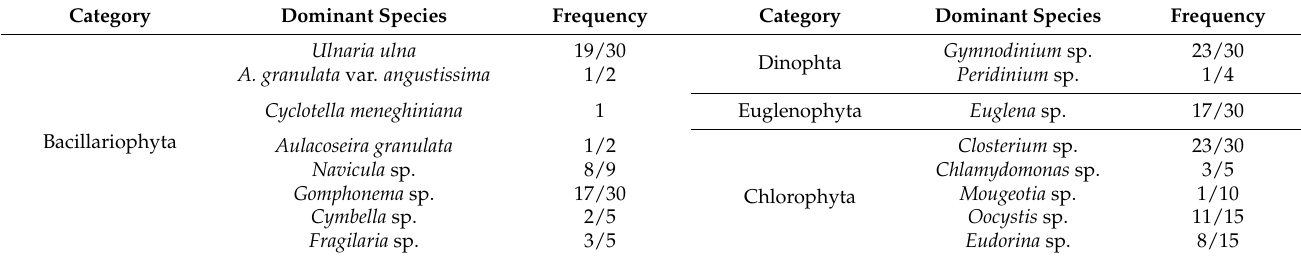
Table 2. Dominant species of phytoplankton in the Huaihe River Basin.